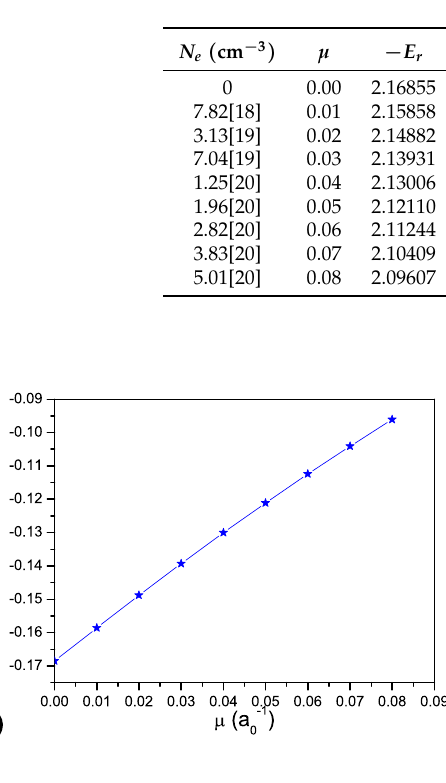
Table 2. Resonance energy E r (in a.u.) and width Γ (a.u.) in He − ( 1 s 2 s 2 2 S ) for various values of the screening parameter µ (in a − 1 ) corresponding to kT = 4.0 eV obtained by using the wave function (5). 0 ( e ) Γ ( e ) denote our estimation as mentioned in the text. The notation x[y] means x × 10 y . E r and